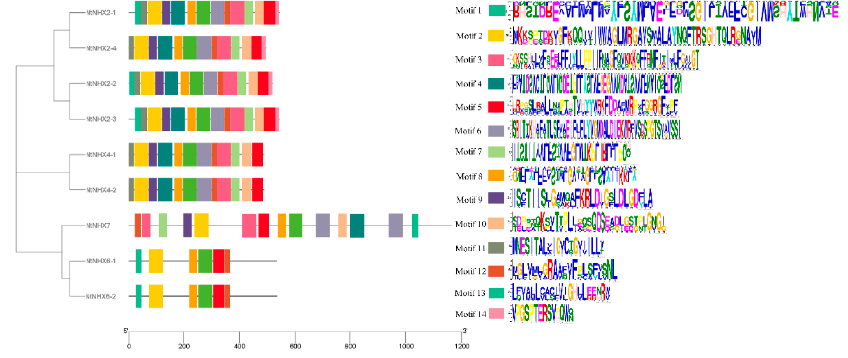
Figure 12. Conserved motif analysis of NtNHXs .